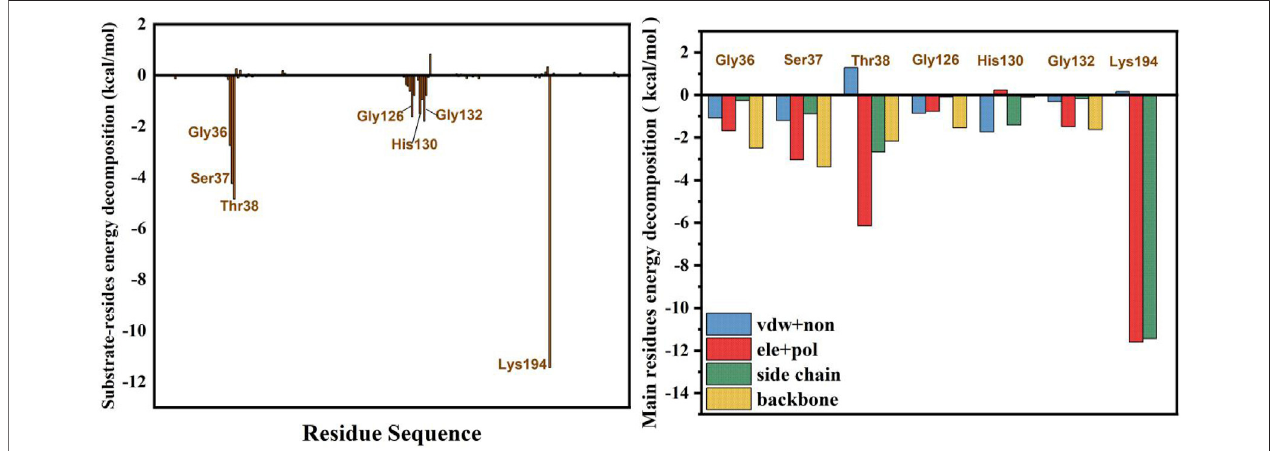
FIGURE 4 | Binding free energy decomposition for the